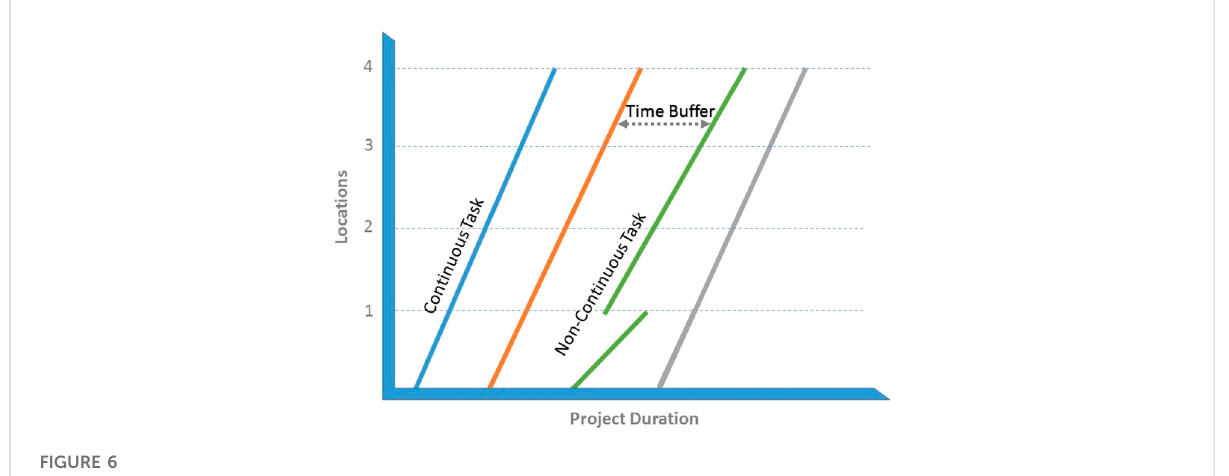
FIGURE 6 Continuous and non-continuous